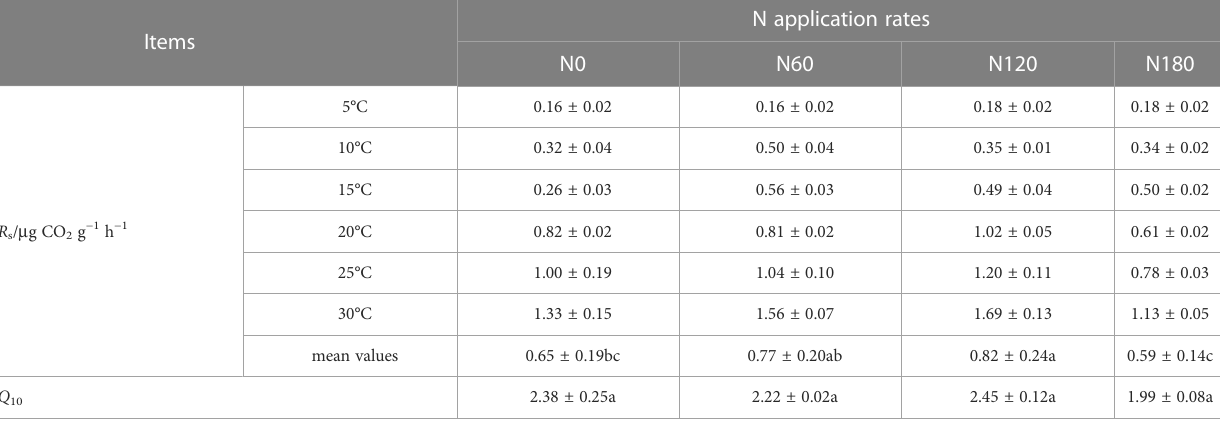
TABLE 3 Soil respiration rate ( R s ) and its temperature sensitivity ( Q 10 ) of each treatment under increasing temperature from 5°C to 30°C.